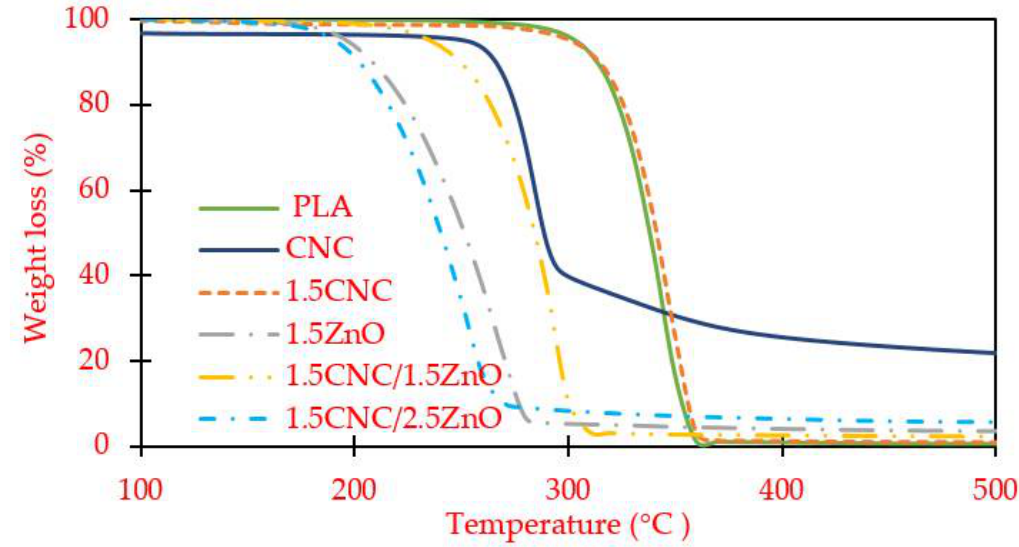
Figure 7. Percentage weight loss vs. temperature for each formulation.